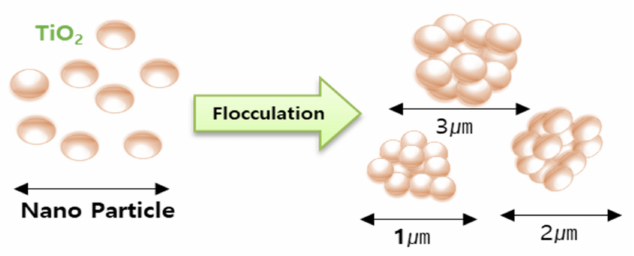
Figure 10. Flocculation of nano particle TiO 2